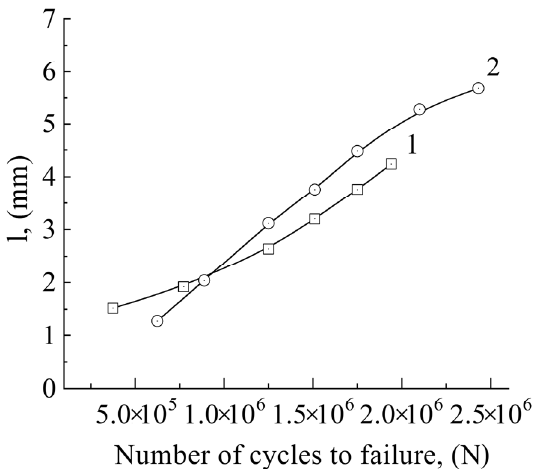
Figure 10. The longitudinal dimension of the heat release zone as a function of the number of loading cycles at the amplitude σ = 195 MPa and the temperature 86 ° С ; 1—CG sample; 2—UFG cycles at the amplitude σ = 195 MPa and the temperature 86 ◦ C; 1—CG sample; 2—UFG sample. sample.